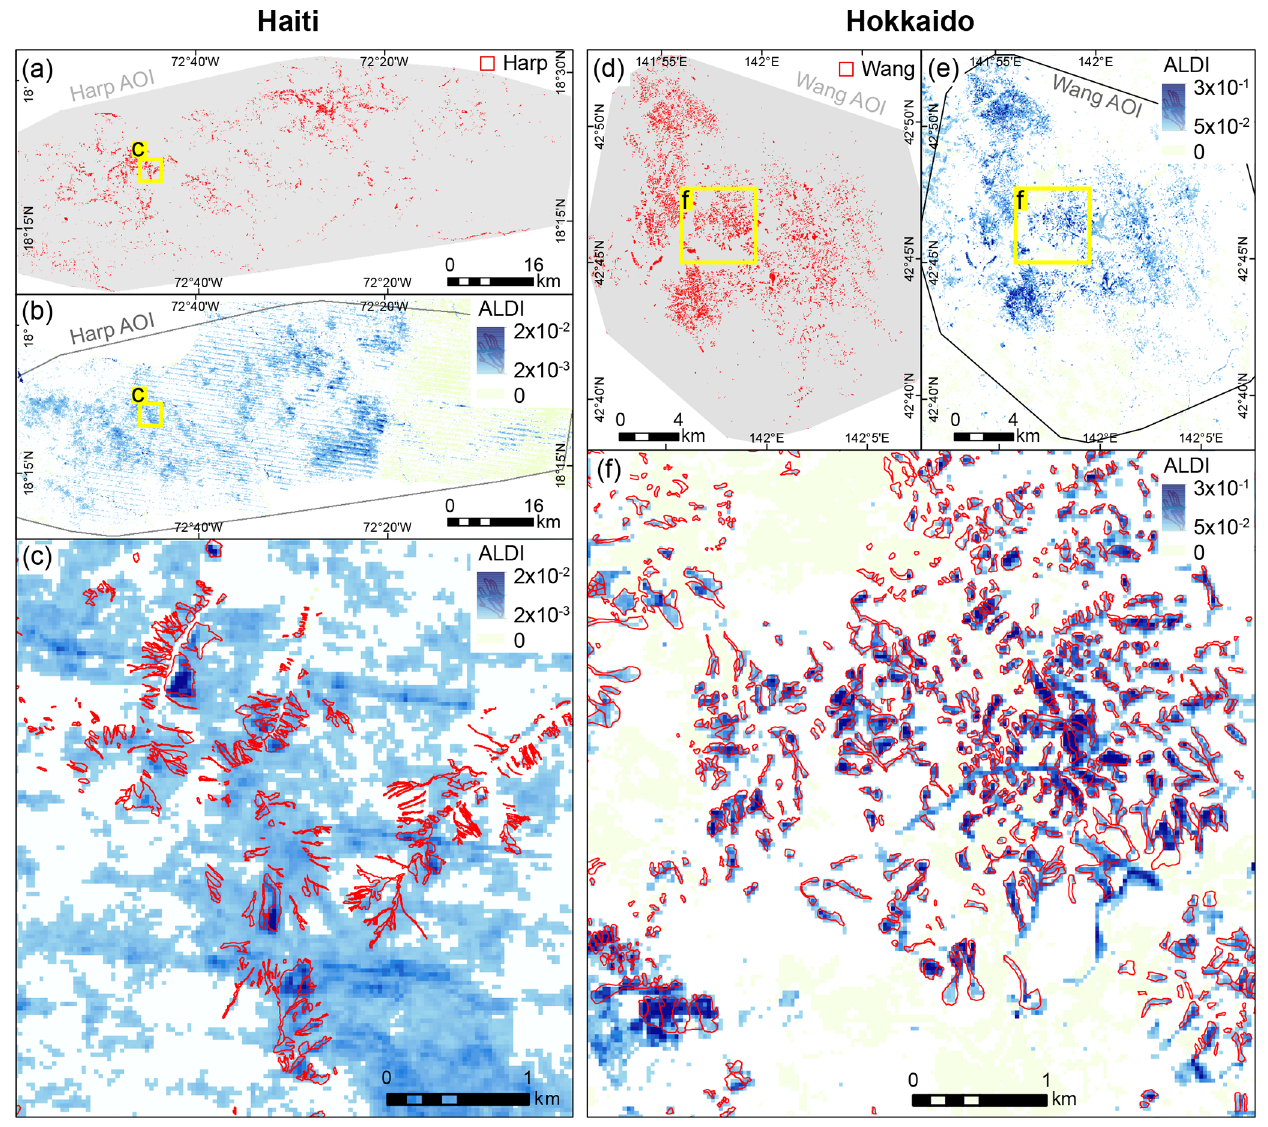
Figure 9. Mapped landslides and the ALDI classifier for the Haiti (left) and Hokkaido (right) study sites. (a) Mapped landslides from Harp et al. (2016) in Haiti at the scale of the full study area with the associated AOI shown in grey. (b) ALDI values for the full study area; the yellow box shows the location of panel (c) . (c) ALDI values overlain by mapped landslides from Harp et al. (2016) for a subset of the study area. (d) Mapped landslides from Wang et al. (2019) in Hokkaido at the scale of the full study area with the associated AOI shown in grey. (e) ALDI values for the full study area. The yellow box shows the location of panel (f) . (f) ALDI values overlain by mapped landslides from Wang et al. (2019) for a subset of the study area. ALDI uses Landsat 5 and Landsat 7 for Haiti and Sentinel-2 for Hokkaido, both gridded at 30m